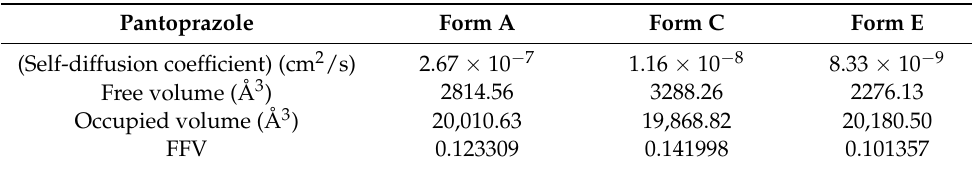
Table 5. Parameters for the corrosion thin-film model construction.